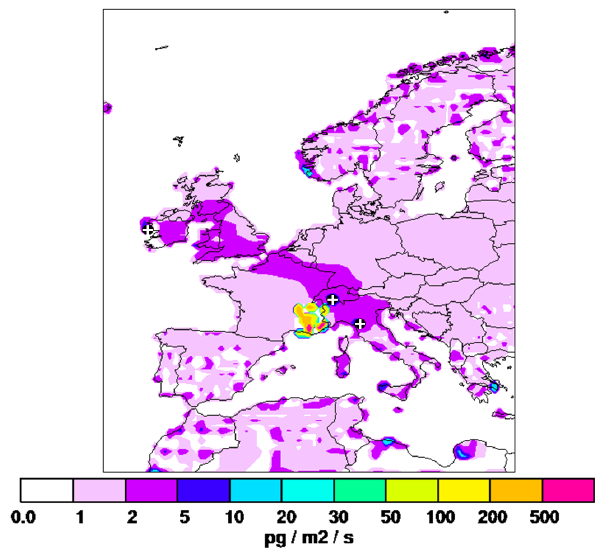
Figure B2. As in Fig. B1 but using the BI-2